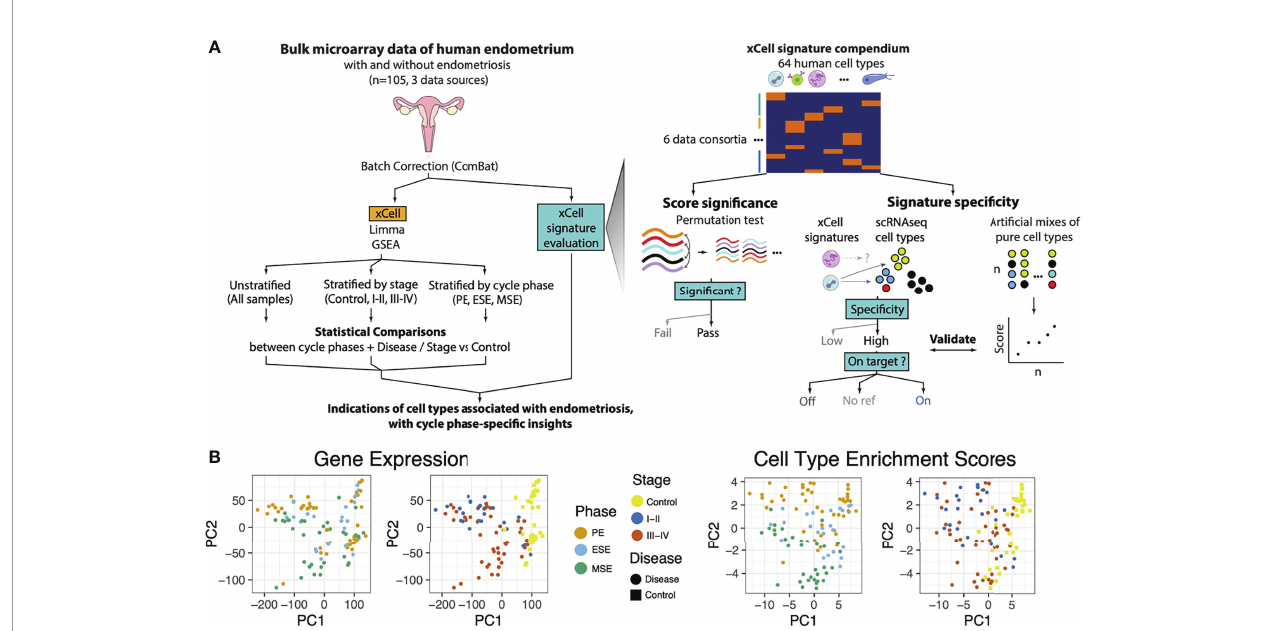
FIGURE 1 | Analysis and Data Overview. (A) Experimental overview showing how endometrial tissue transcriptome microarray data were processed and analyzed. Data were normalized (see below) and batch corrected. Then, differential gene expression (DGE) analysis was performed with log-fold change outputs run through pathway enrichment analysis. Similarly, cell-type deconvolution of these bulk tissue samples was performed and validated and then analyzed for differential enrichments between sample groups. Each of these analyses was run for various strati fi cations (subsets) of the samples and targeting differences between distinct groupings for each strati fi cation. These analyses were used to identify, with cycle phase-speci fi c insights, pathways and cells associated with endometriosis. A zoom of how xCell signatures were evaluated and selected to be representative of endometrial tissue. Left: Permutation test: Microarray transcriptome data were permuted at the gene level to construct tissue-speci fi c null distributions for xCell ’ s outputs of its 64 signatures. Right: Microarray transcriptome data from sorted cells were summarized and combined at different ratios into arti fi cial mixtures. Then xCell was run on these mixtures. Middle: For each of the 64 xCell signatures, a two-score schematic was designed to evaluate its relationship with respect to each endometrial cell type identi fi ed in the single-cell RNAseq dataset (27). A speci fi city score (ratioNext) was agnostically quanti fi ed and each xCell signature was categorized as either targeted or nontargeted (NA: no ref) based on whether there is an endometrial cell type or subtype that the signature is targeting, and “ On Target ” or “ Off Target ” based on whether the top-ranking endometrial cell type is the signature ’ s intended target or not, respectively. (B) Principal component analysis (PCA) of samples, after batch correction, based on (left) transcriptome data or (right) cell-type enrichment scores and colored by menstrual cycle phase or disease